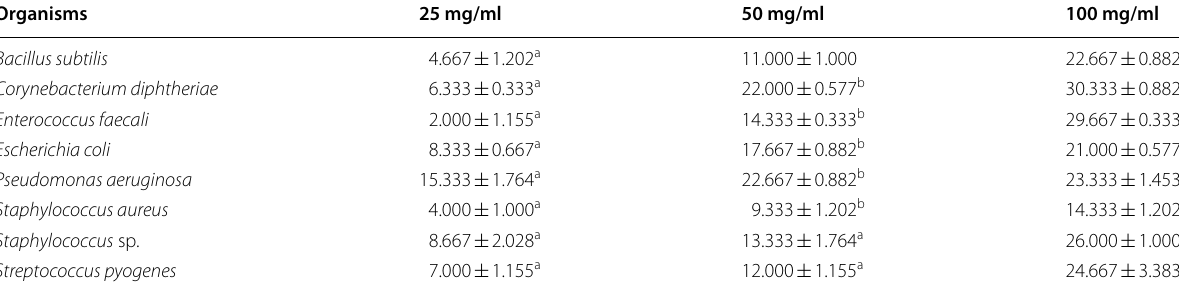
significantly different at p < 0.05 =